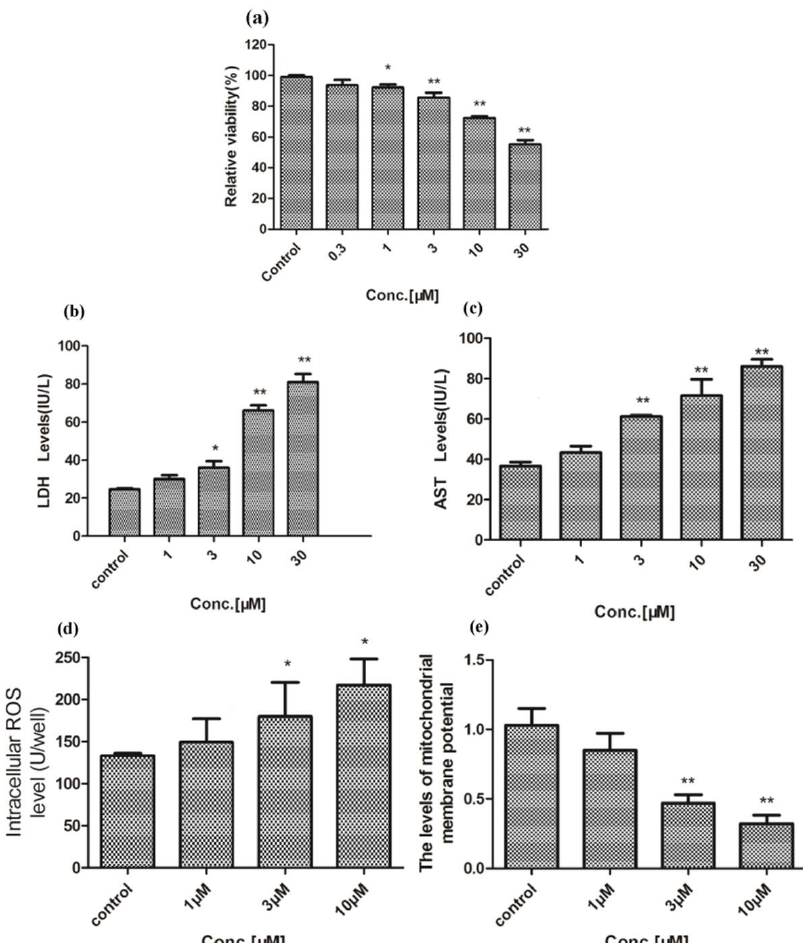
Figure 2. The toxicity of celastrol on primary rat hepatocytes. ( A ) The relative viability after treatment with a series of concentrations of celastrol. ( B ), ( C ), ( D ) The effects of celastrol on LDH, AST, and ROS productions in rat primary hepatocyte, respectively. ( E ) The MMP after administration of different concentrations of celastrol. Compared with the control cells, * p < 0.05, and ** p < 0.01.